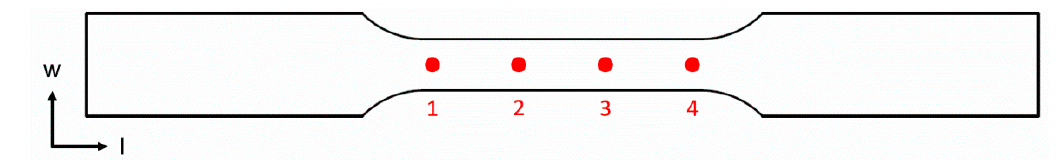
Figure 3. Positions selected for residual stress measurement.